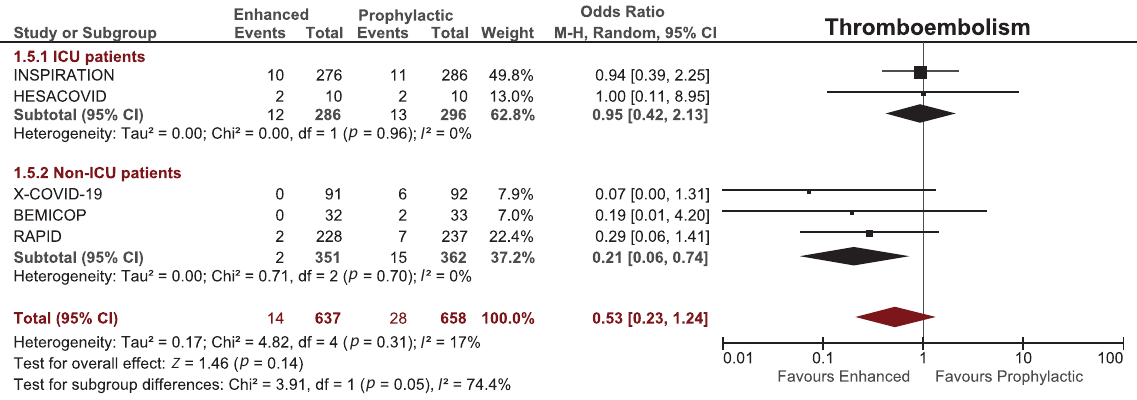
Fig. 6 Subgroup analysis of thromboembolism in ICU and non-ICU patients who received enhanced (therapeutic/intermediate) versus prophylactic anticoagulation. CI, con fi dence interval; ICU, intensive care unit.